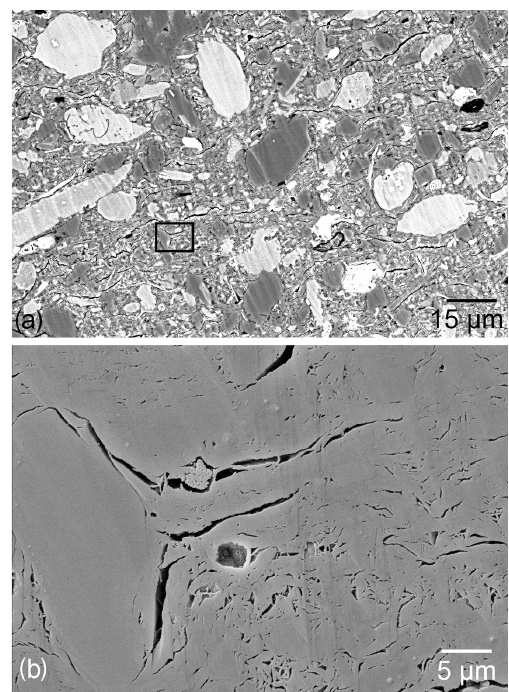
Figure 4. (a) BSE–SEM micrograph of the typical mineral fabric in undeformed COX. (b) SE2 SEM micrograph of a detail indicated by the black box in (a) showing the typical pore fabric in undeformed COX. In both micrographs, the bedding is